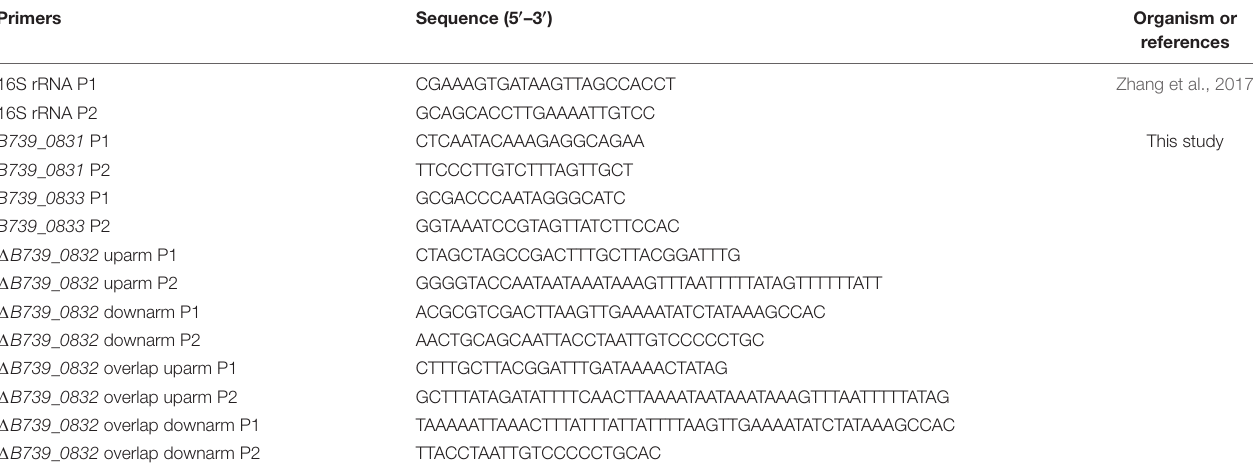
TABLE 2 | Primers used in this